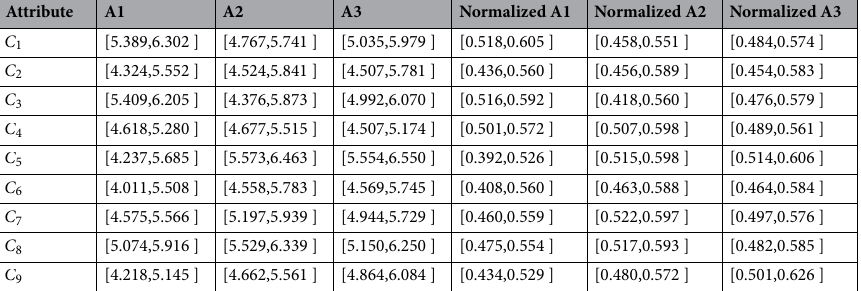
Table 7. Step data of preference value (PV)